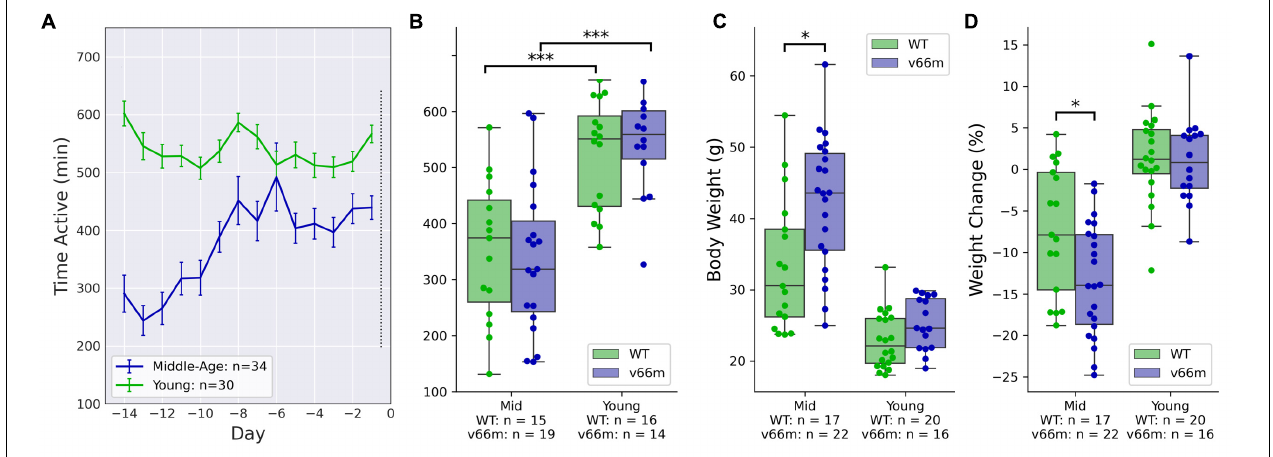
FIGURE 1 | Mice at baseline. Mice ran freely in running wheel cages for 2 weeks before receiving any injections. (A) VWRA (time active) on the running wheels for each baseline day. The young mice consistently ran more than middle-aged mice. (B) For both Val66Met (“v66m”) and WT, young mice had higher average baseline VWRA than middle-aged (“Mid”) mice ( p < 10 – 3 ), but there were no significant baseline differences between Val66Met and WT mice. (C) The Val66Met mice were larger than WT controls. Weight differences between genotypes were statistically significant when comparing only middle-aged mice ( p = 0.0059). (D) Middle-aged but not young mice lost weight during the 2 weeks of baseline wheel running. The middle-aged Val66Met mice lost more weight than their WT controls ( p = 0.016), even after adjusting for their higher initial bodyweight ( p = 0.0011). ∗ p < 0.05, ∗∗∗ p <